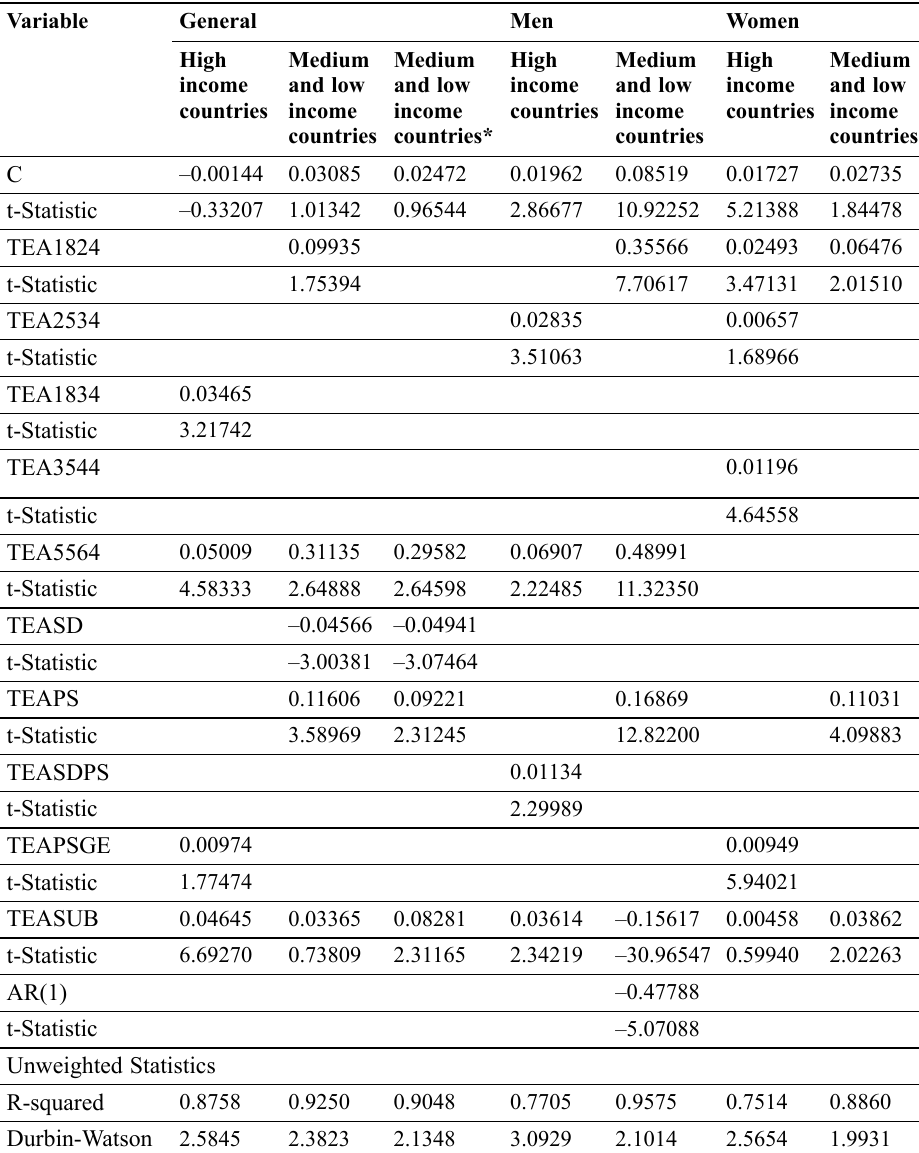
Table 5. Estimation results, grouped according to country income level: 2002–2006